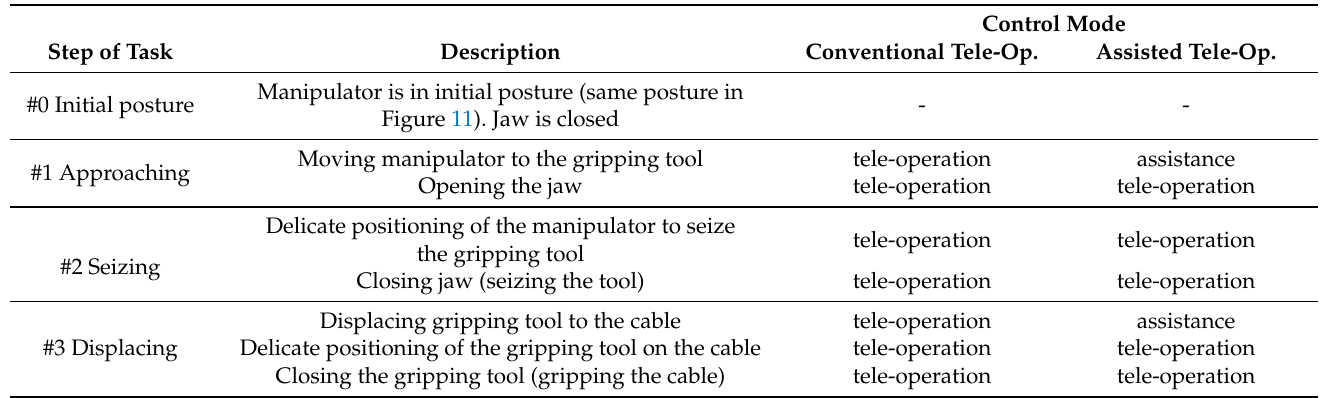
Table 2. Detailed description of the task.